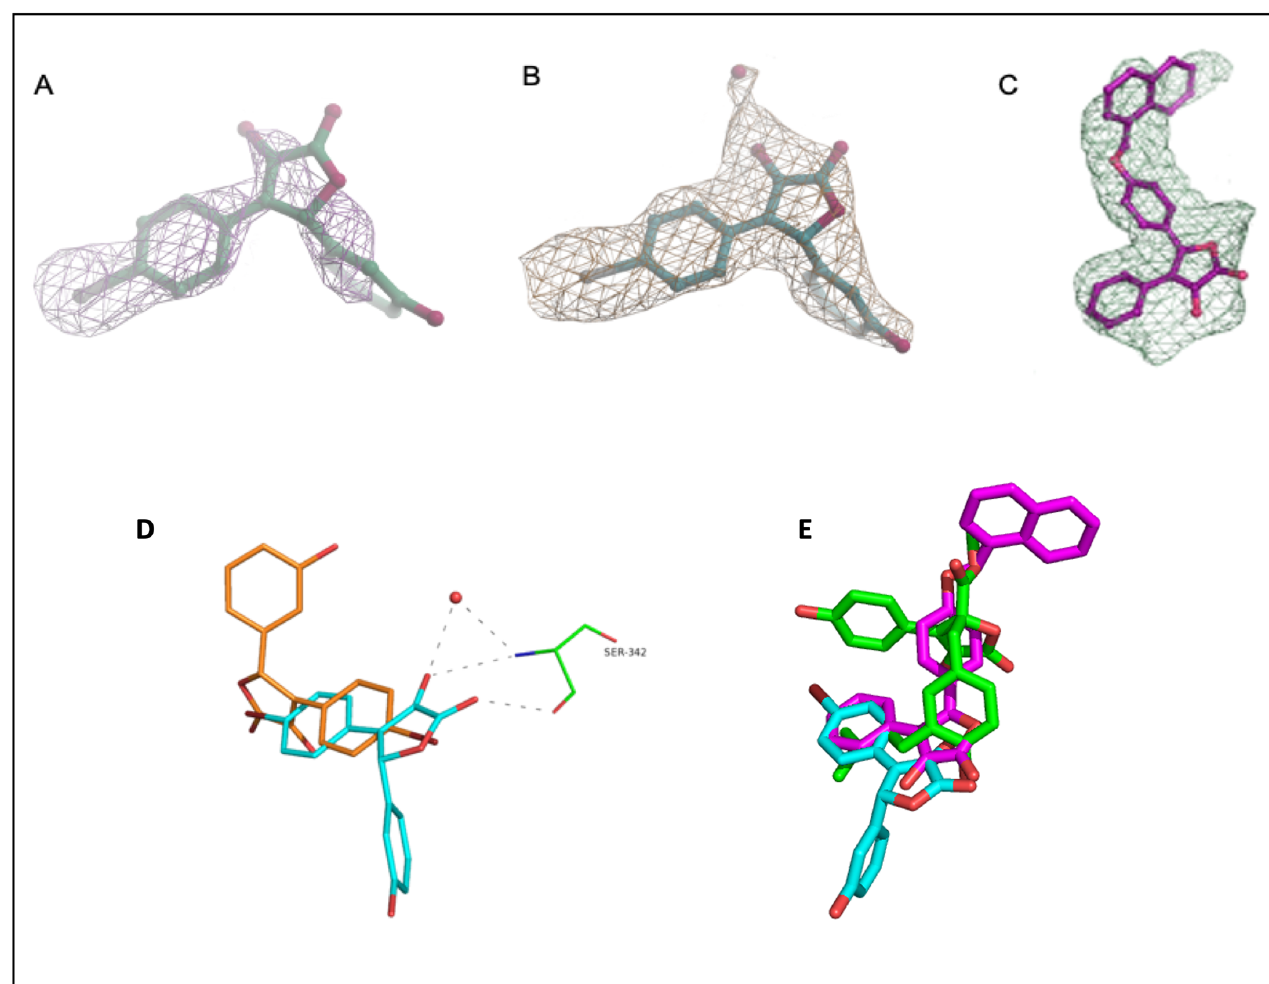
Figure 5. Electron density maps of 1 and 3 in chain B of PPAR γ‐ LBD. ( A ) F o ‐ F c omit map of 1 , countered at 2 σ ; ( B ) model ‐ refined 2F o ‐ F c map of 1 countered at 1 σ . The water molecule HOH205 is depicted as a red sphere; ( C ) polder (omit) map of compound 3 , countered at 3.5 σ ; ( D ) superposition of compound 1 within molecule A (orange) and B (cyan) dashes represent interactions of compound 1 with Ser342 and water 205 in molecule B; ( E ) superposition of 1 (cyan), 3 (pink), and BLI (green) in the complex with PPAR γ‐ LBD.